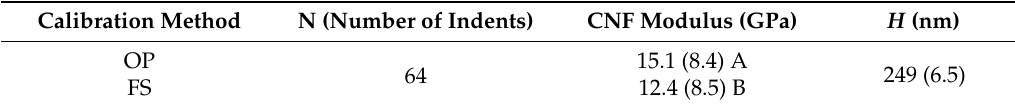
Table 2. The nanomechanical properties of CNF.